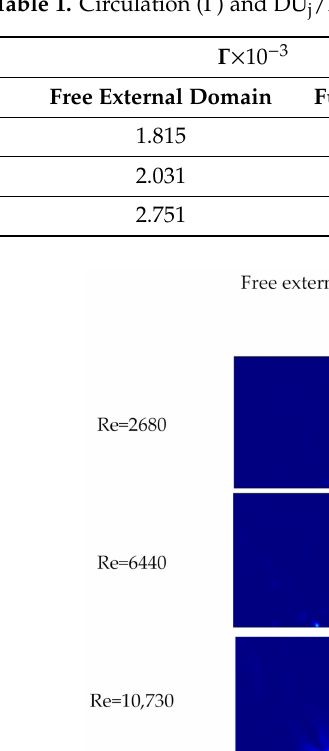
Figure 9. Time-averaged Q-criterion contour of free and fully confined external domain at di ff erent Reynolds number.